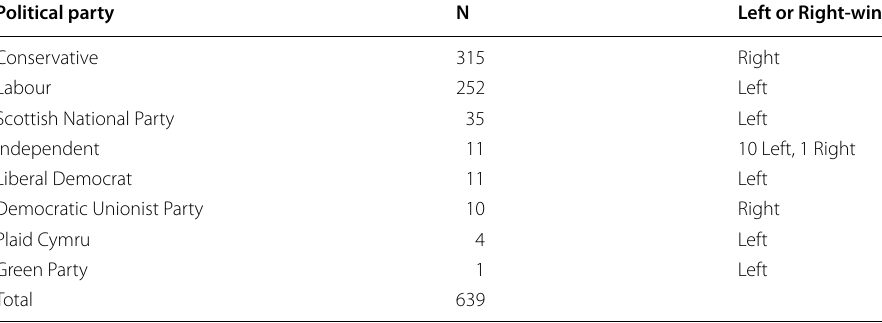
Table 1 Overview of the MPs under study and their party affiliations Political party N Left or Right-wing Conservative 315 Right